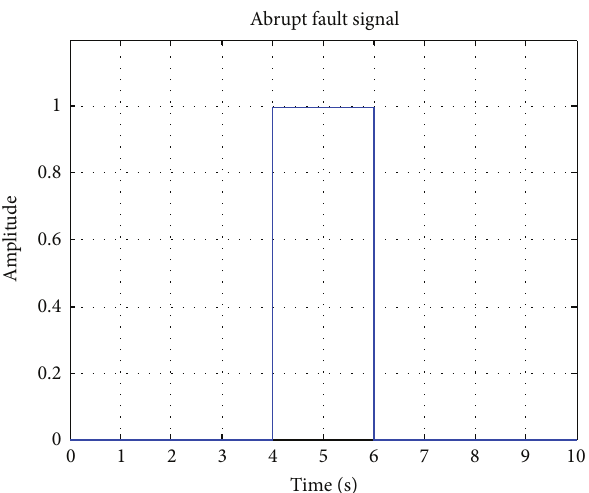
Figure 1: An abrupt fault occurs at 𝑡 = 5